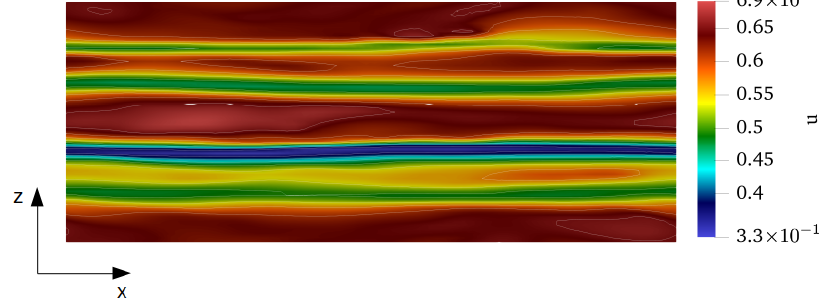
Figure 17. Instantaneous streamwise velocity contour at a xz plane—MMF.